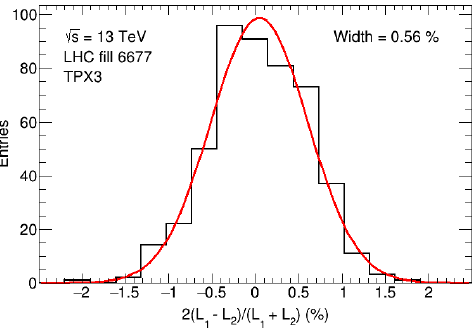
Figure 66. Gaussian fit of the relative difference between the luminosities measured by layers 1 and 2 of the TPX3 device as a function of time, using cluster-counting in LHC fill 6677. Taken from Ref.